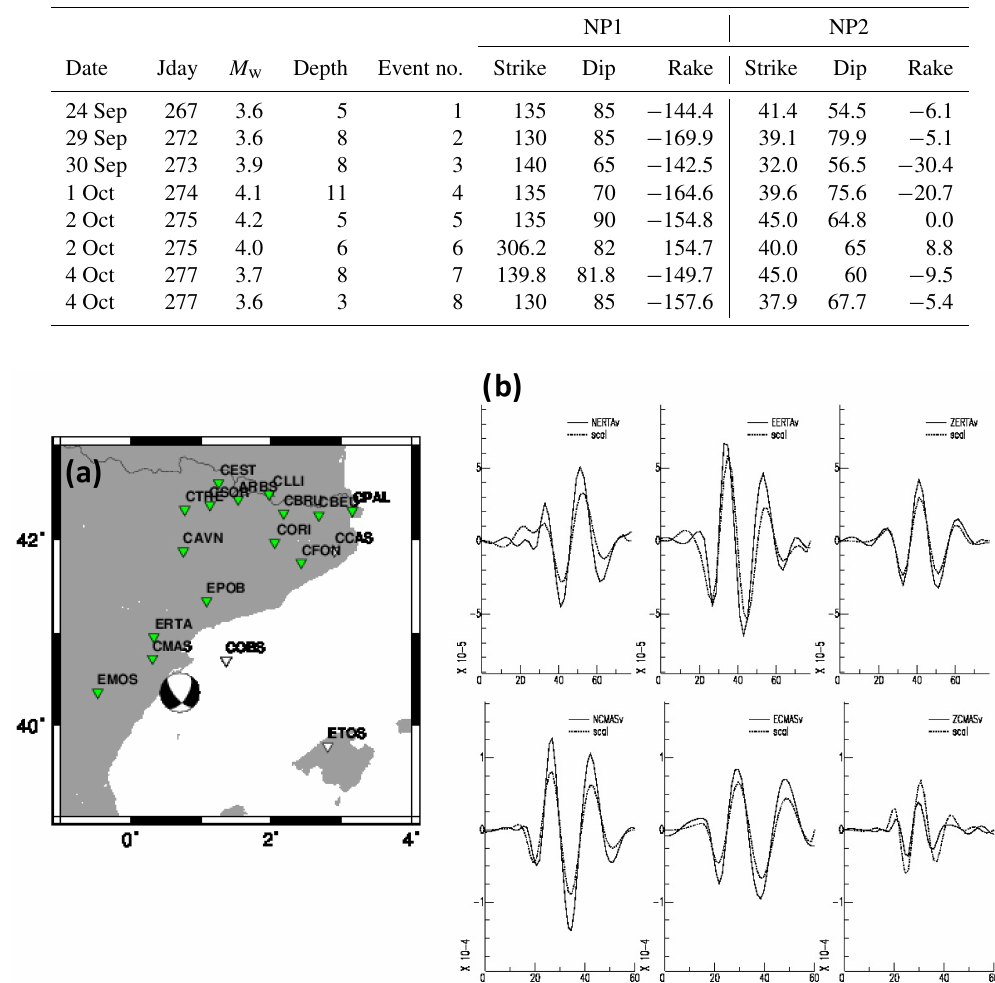
Figure 3. (a) Output map with the FM solution for the M w 3.9 that occurred on 30 September 2013, its location, and the stations used to compute it (green triangles). (b) Waveform fit at stations ERTA and CMAS for the named event. The recorded waveforms are plotted with a continuous line; the discontinuous line is